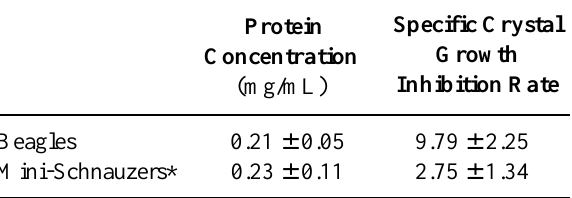
Table 2 – Comparisons of urinary protein concentration and calcium oxalate crystal inhibition activity.